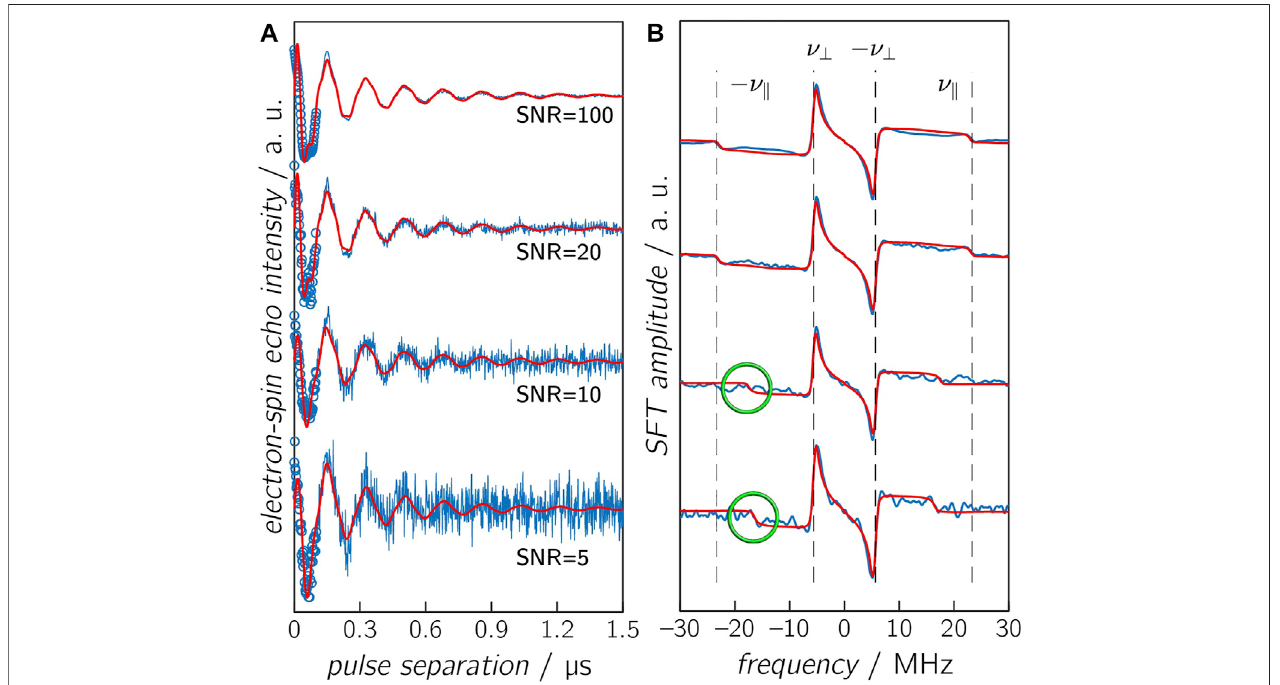
FIGURE 4 | Calculated OOP-ESEEM time traces (A) and corresponding SFT spectra (B) . Calculated time trace ( D = − 14.5 MHz and J = 2 MHz), including reconstruction with the AR model (circles) and various SNR levels, are depicted in blue, and results from numerical simulations are depicted in red. The vertical dashed lines in the SFT spectra are the correct frequencies ] (cid:3) and ] ⊥ . Please note that calculated and simulated frequency ] (cid:3) are only identical in case of an SNR ≥ 20, and differences are highlighted in green. Other parameters are summarized in Table 3 .